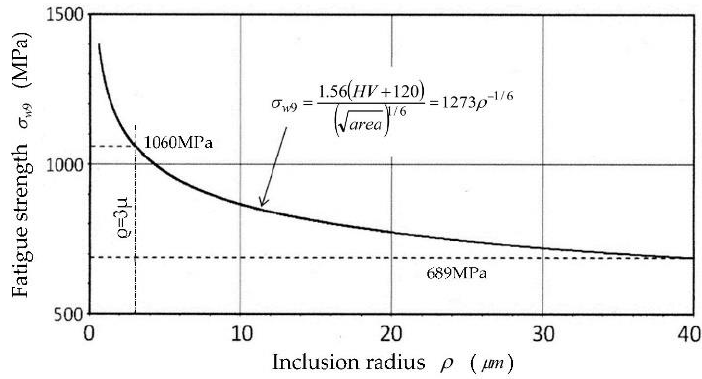
 and inclusion radius  . Figure 3. Relationship between fatigue strength σ w 9 and inclusion radius ρ 9 w